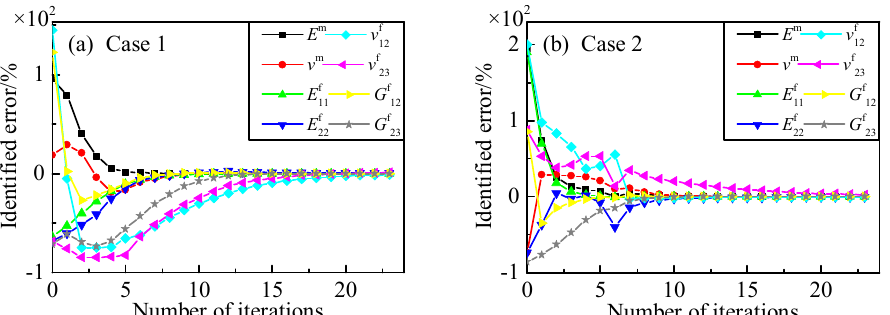
Figure 8. Constituent parameter identification with seven points using direct derivation. ( a ) initial values: E m = 8 GPa, ν m = 0.45, E f11 = 100 GPa, E f22 = 6 GPa, ν f12 = 0.49, ν f23 = 0.1, G f12 = 60 GPa, G f23 = 2 GPa; ( b ) initial values: E m = 12 GPa, ν m = 0.1, E f11 = 800 GPa, E f22 = 5 GPa, ν f12 = 0.6, ν f23 = 0.6, G f12 = 50